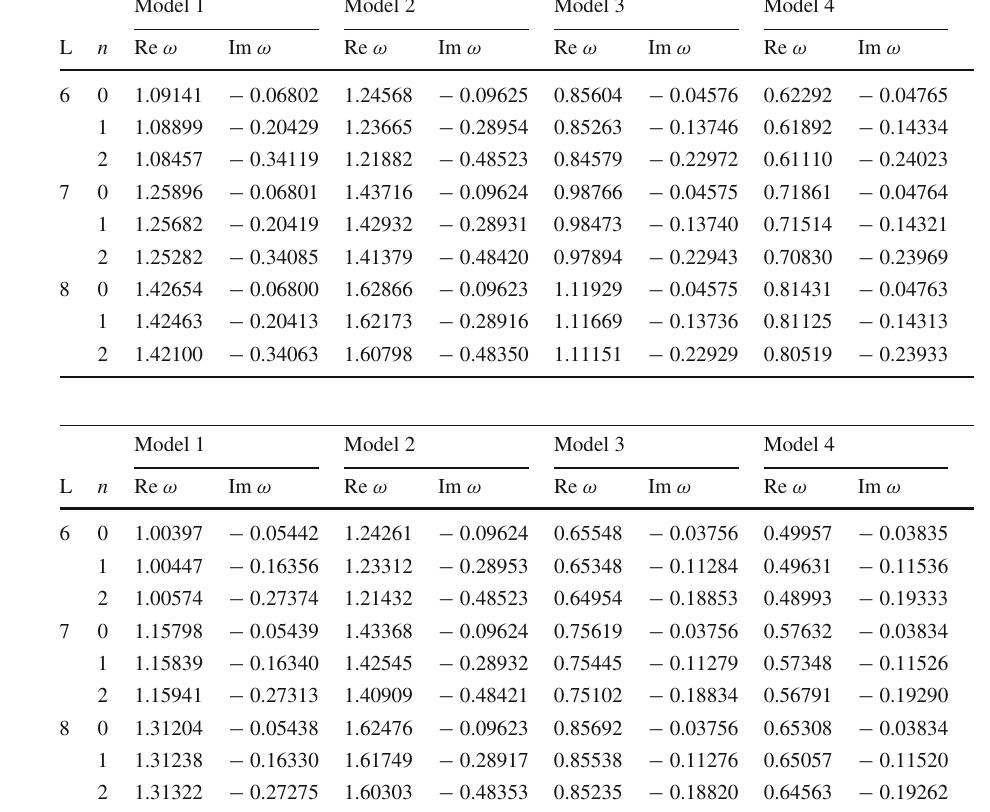
Table 2 Numerical values for Re (ω) and Im (ω) for α = 2